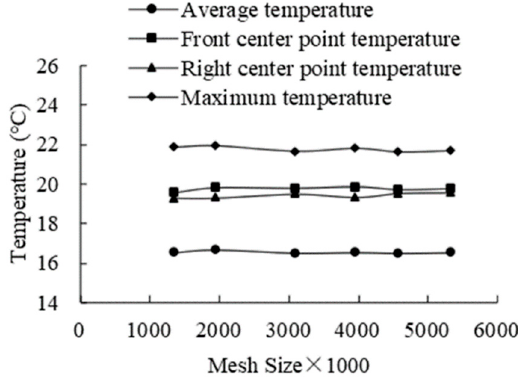
Figure 7 shows the product temperature at the 4 evaluation locations. The product